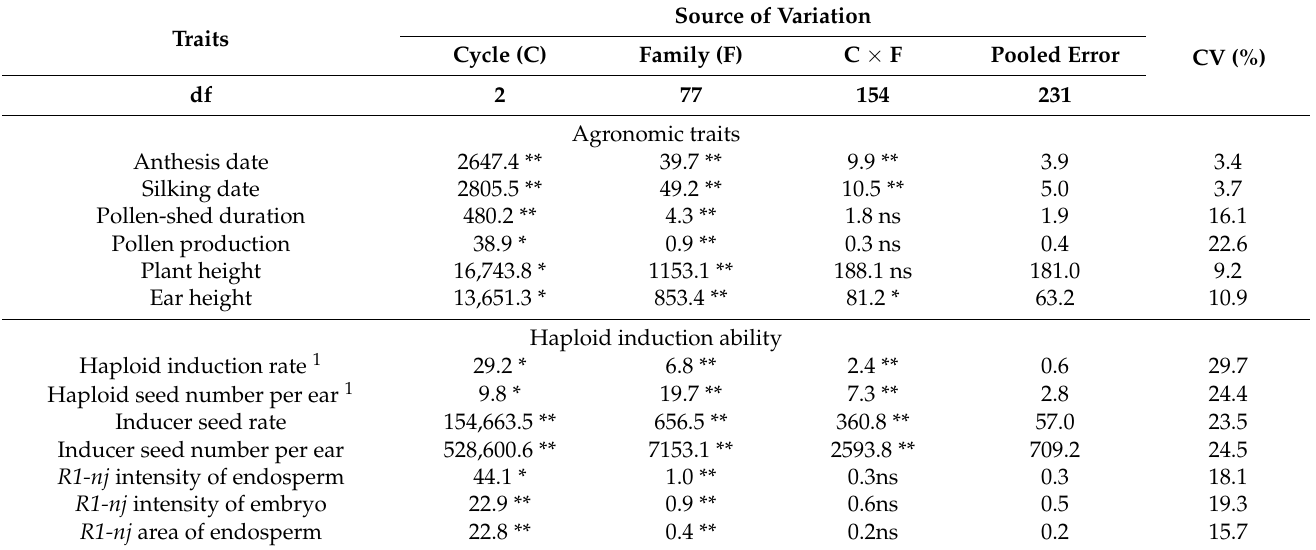
Table 1. Mean squares from the combined ANOVA for haploid induction ability and agronomic traits of 78 putative families across three breeding